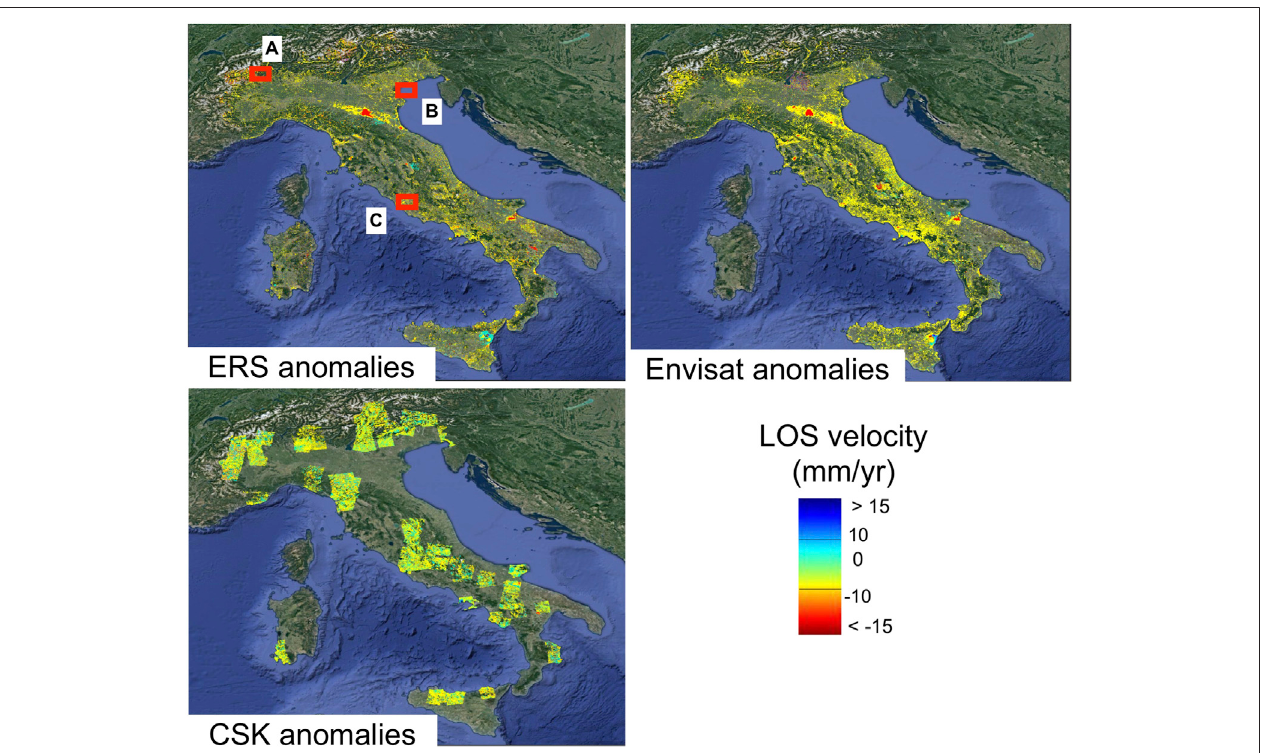
FIGURE3| Anomalies/Positivesignalsidenti fi edbytheNeuralNetwork(NN)algorithmovertheentireItalianterritory.Thesepointsindicateareaswhereachangein deformation larger than 10 mm/year has been detected during the observation period. Red boxes represent areas shown in Figure 4 (box A and B) and Figure 5 (box C). The CSK ERS and Envisat data have been analyzed separately.